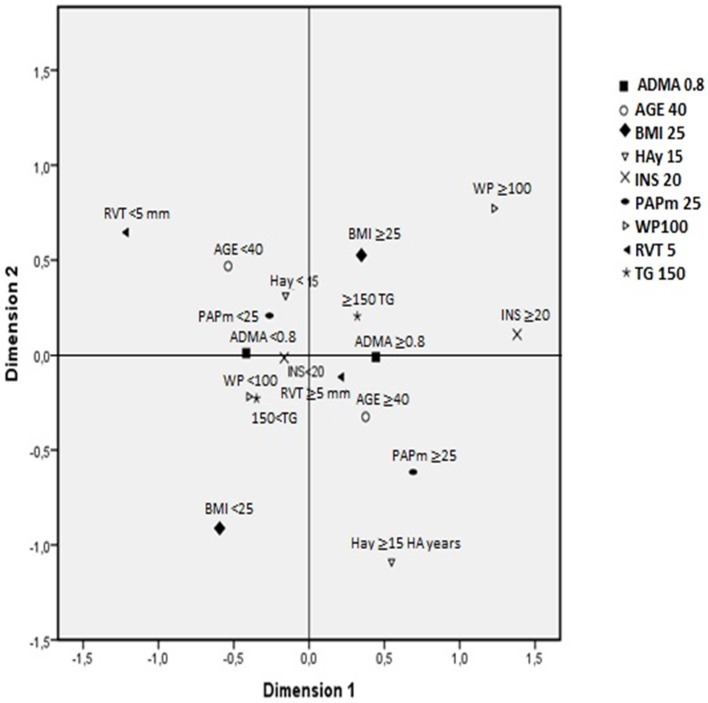
Association patterns between variables by multiple correspondence analysis. Variables and cut-off points: asymmetric dimethylarginine (ADMA; μmol/L; < ≥0.8), age (years old; < ≥40), body mass index (BMI; kg/ m2; < ≥25), high-altitude years (HAy; < ≥15 years), insulin (INS; IU; < ≥20), mean pulmonary artery pressure (PAPm, mmHg; < ≥25), waist perimeter (WP; cm; < ≥100), right ventricle wall thickness (RVT; mm; < ≥5) and triglycerides (TG; mg/dL; < ≥150). Explained proportion of total variance of dimension 1 = 57.3% and dimension 2 = 42%. Cronbach's alpha: 0.594.